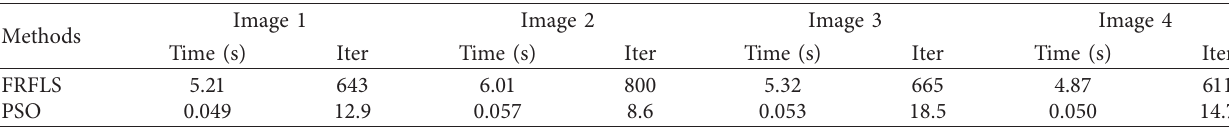
Image size: 320 ∗ 240